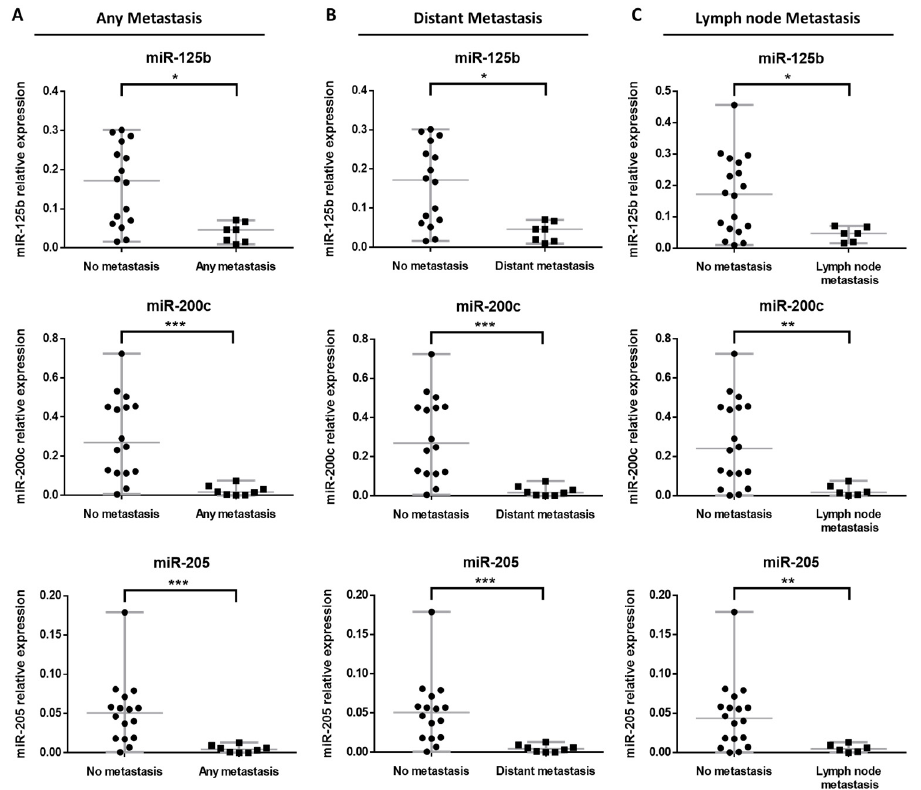
Figure 3. Relative expression of miR-125b, miR-200c and miR-205 according to the metastatic behavior of BRAF WT primary tumors for ( A ) any metastasis, ( B ) distant metastasis and ( C ) lymph node metastasis. Significant at * p -value < 0.05, ** p -value < 0.01 and *** p -value <